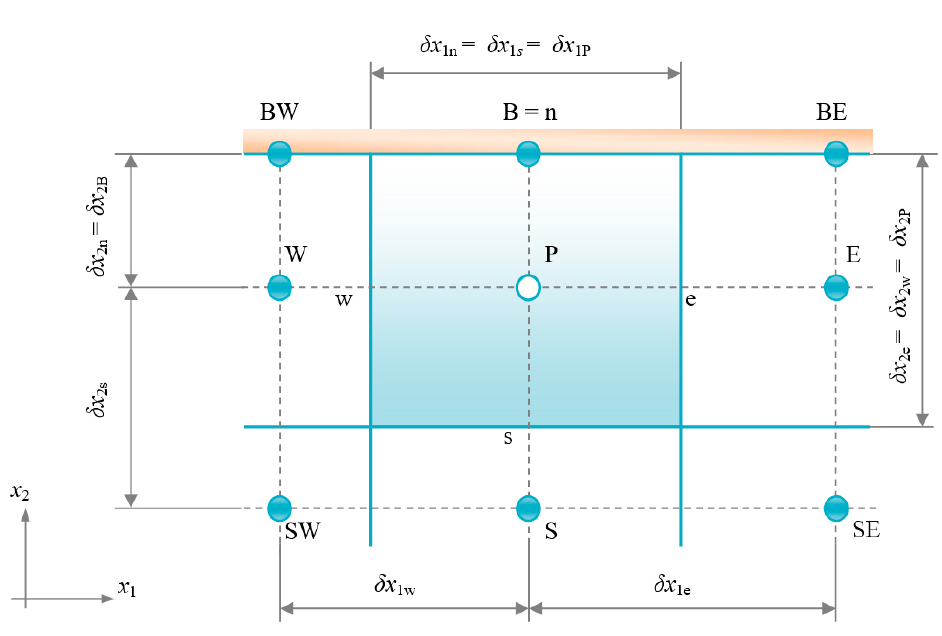
Figure 2. 2D control volume with scheme of labelling.